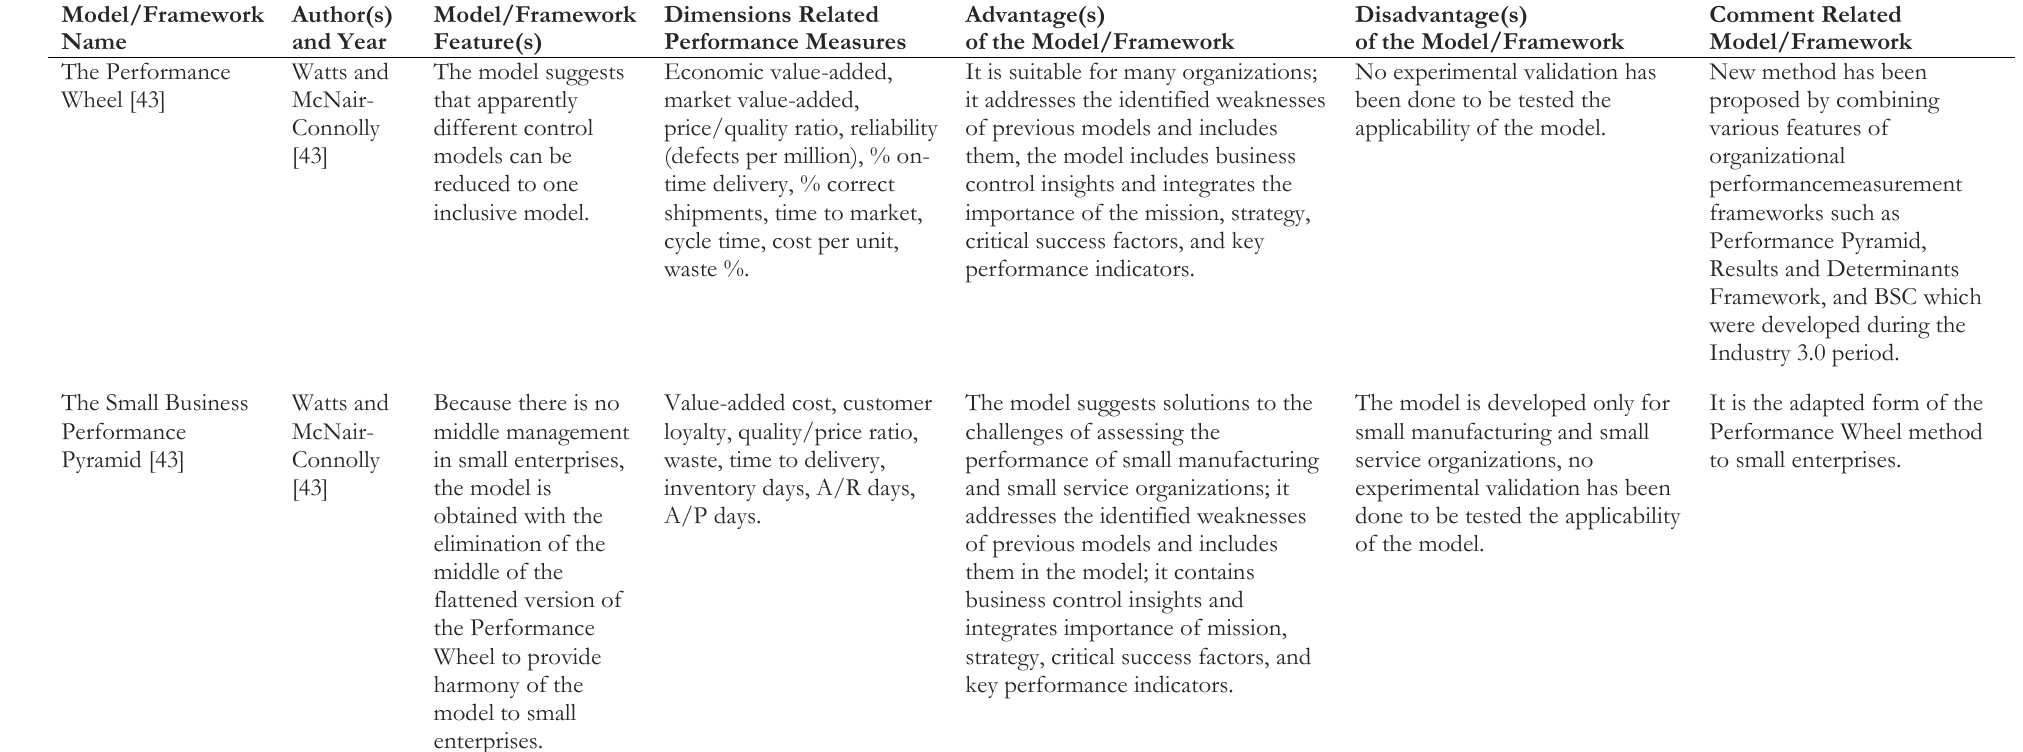
Table 14. Organizational performance measurement models developed in Industry